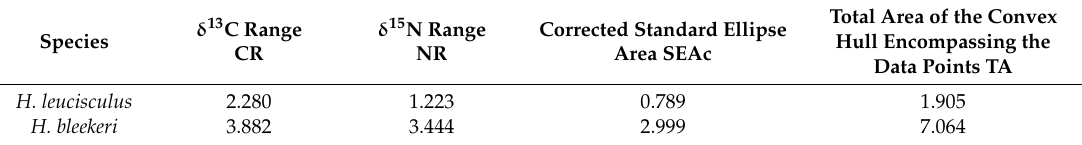
Table 3. δ 13 C range (CR), δ 15 N range (NR), corrected standard ellipse area (SEAc), and total area of the convex hull encompassing the data points (TA) of H. leucisculus and H. bleekeri at the Mudong site. Total Area of the Convex δ 13 C Range δ 15 N Range Corrected Standard Ellipse Hull Encompassing the Species Area SEAc CR NR Data Points